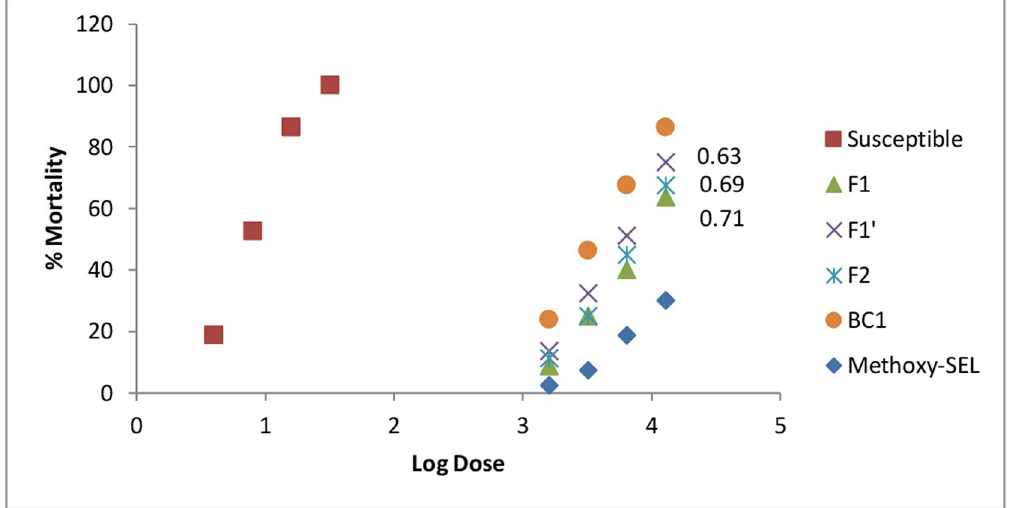
Fig 3. Percentage mortality of various crosses and strains with D LC values.